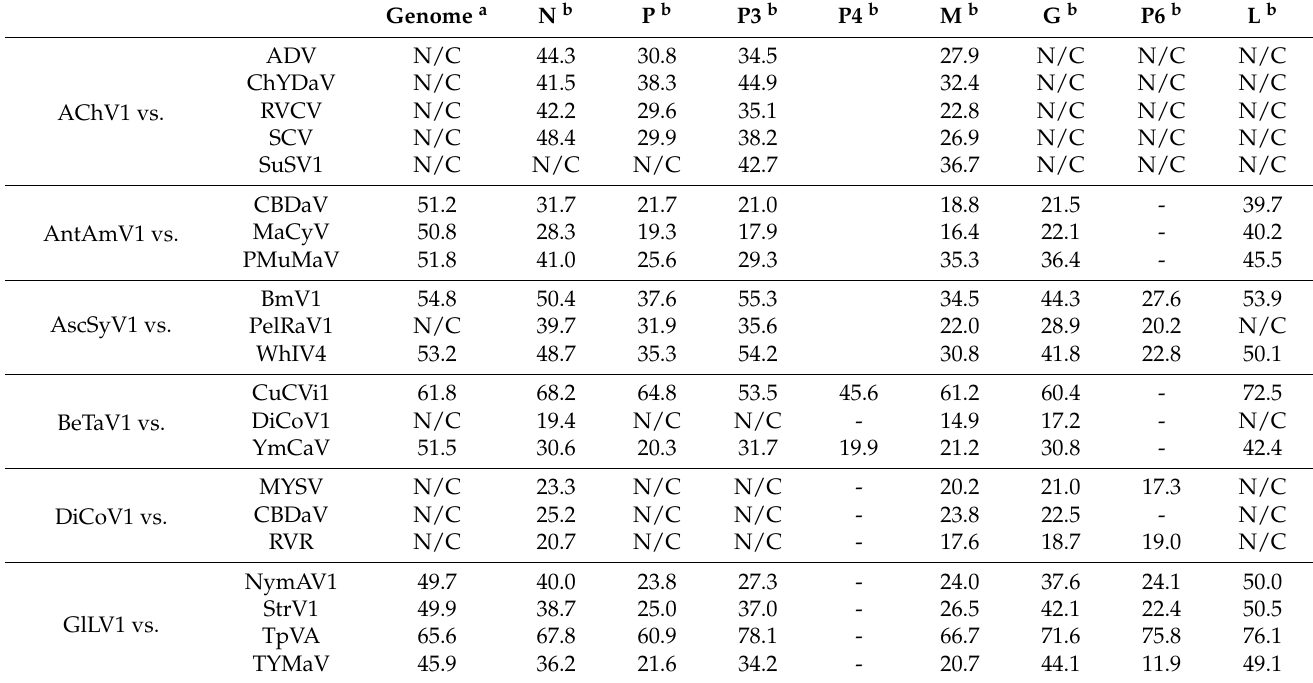
Pairwise identity percentages between the cytorhabdoviruses assembled in this study and the selected cytorhabdovirus.